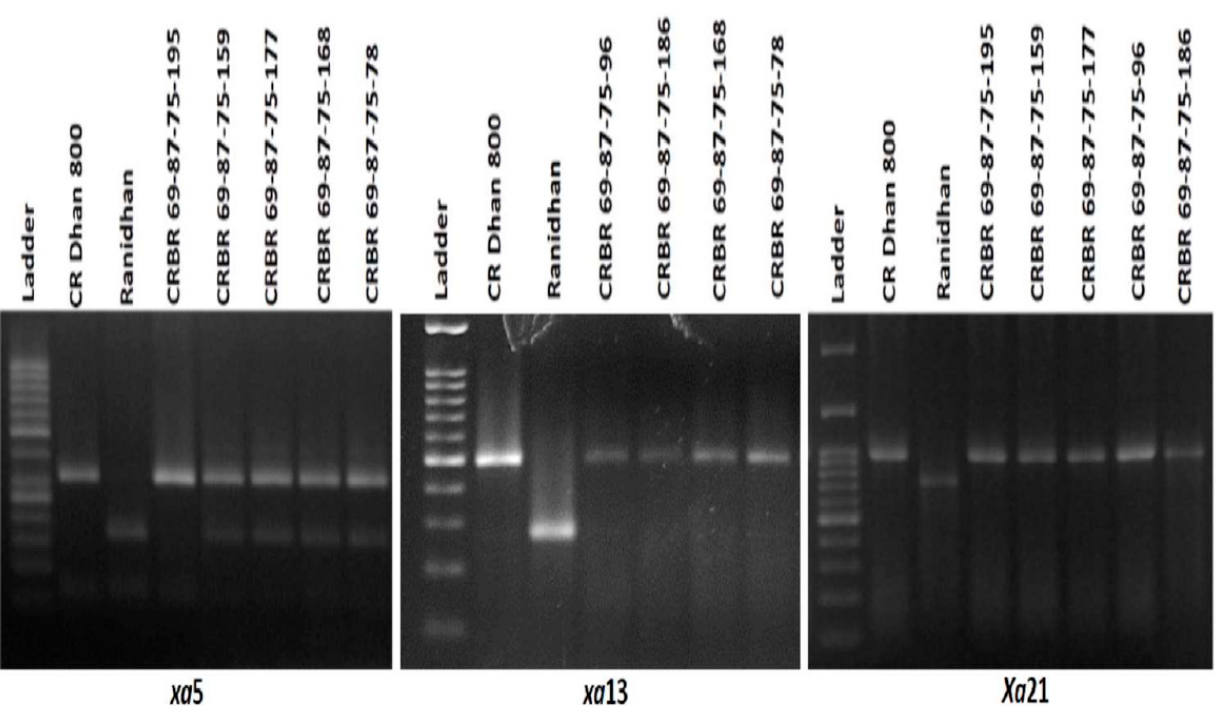
Figure 5. Representative electropherogram generated from the tracking of Xa21 , xa13 and xa5 BB resistance genes in BC 3 F 2 progenies of resistance gene pyramiding of Ranidhan.